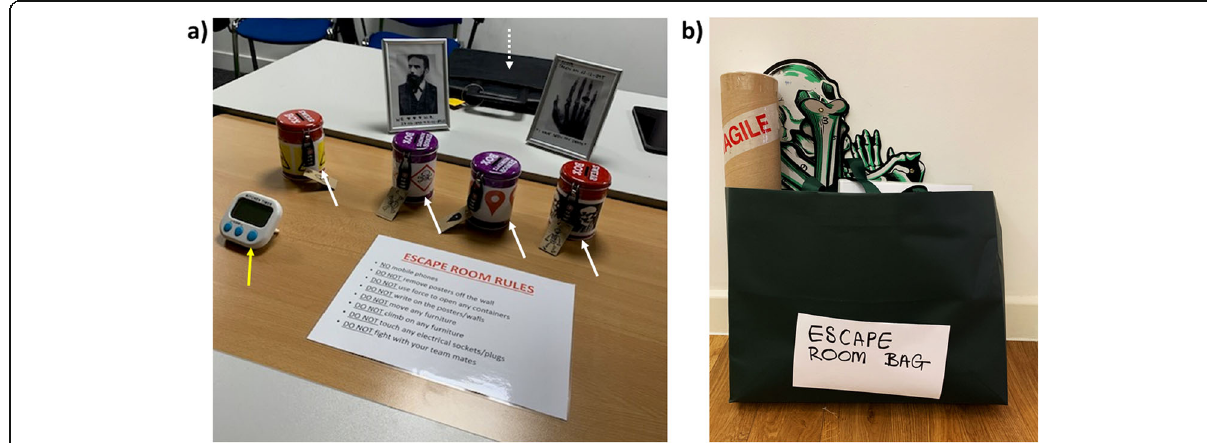
Fig. 5 Equipment in the escape room. a The equipment on the central desk included a copy of the escape room rules, the kitchen timer to time the participants (yellow arrow), the four tin containers (white arrow) which were each locked with a three-number combination lock and contained a note for the final crossword puzzle, and clues on how to unlock the briefcase containing the puzzle (dashed white arrow). Photo frames containing images of Roentgen and an early example of a hand radiograph were not part of the escape room puzzles, and only placed on the table for decoration. b All the equipment was easily transportable between teaching sites within a single carry